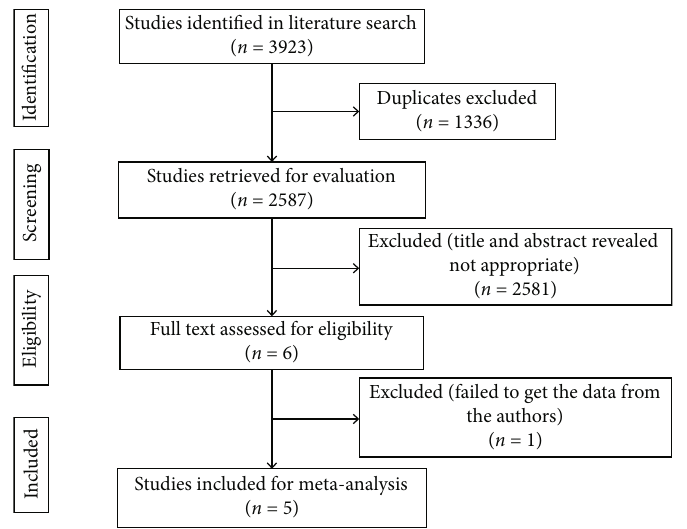
Figure 1: Flow diagram of search